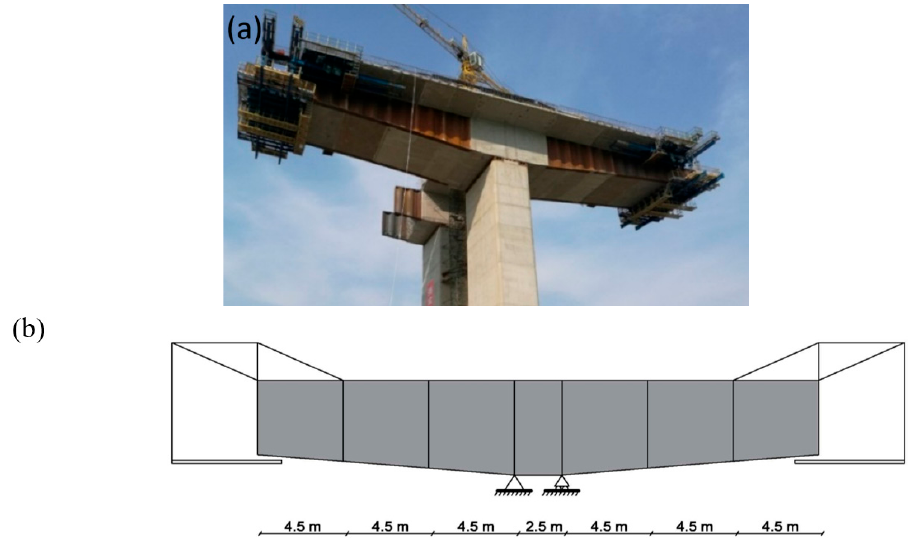
Figure 10. Example of application: ( a ) Yunbao Bridge under construction [52] and ( b ) a sketch of the analyzed construction stage.